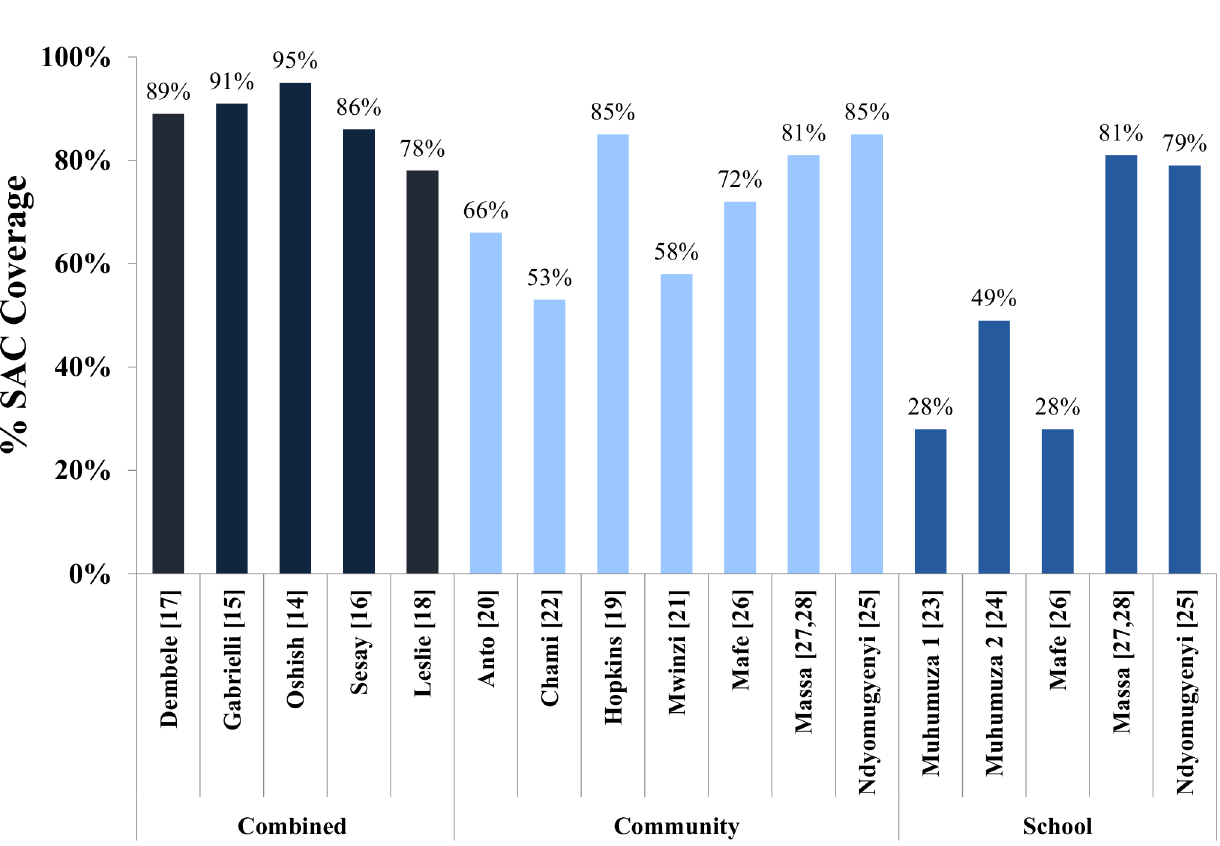
Fig 2. Anti-schistosomal drug treatment coveragerates by delivery method. The reportedMDA coveragerates for SAC in each study are shown, groupedby delivery method (combined, community-only, or school-only). Each study is identified by its reference citation